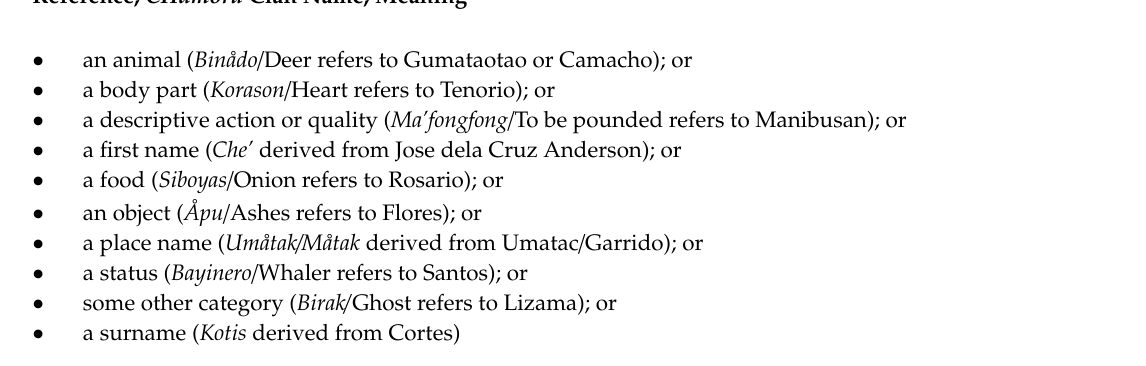
Table 1. Sample of CHamoru Clan Names with